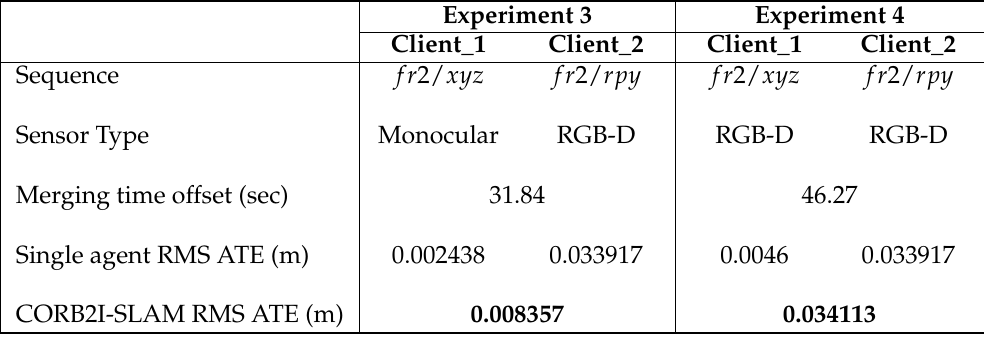
Table 3. Quantitative details for experiment on Freiburg2 sequences.